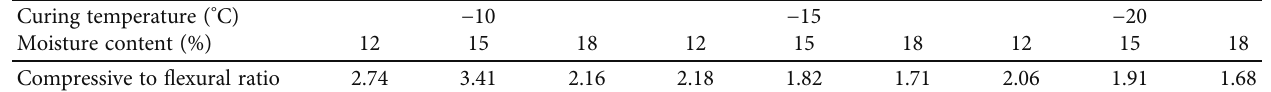
Table 4: Compression ratio of frozen soil under di ff erent in fl uencing factors.